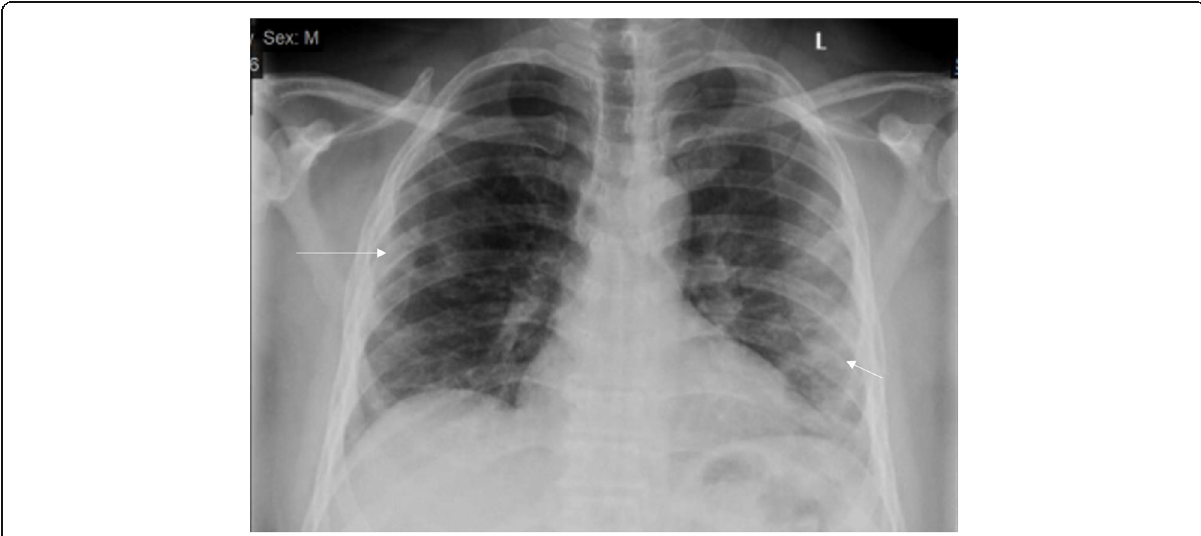
Fig. 11 54-year male patient with positive COVID-19. He was complaining of cough and fever. Follow-up chest X-ray showed right midzonal lesion with central lucency giving atoll sign (long arrow) of organizing pneumonia. Also, left lower zonal small air space consolidation opacities with reticular thickening was seen (short arrow). The severity score was 1 for each lung, so the total severity score was 2